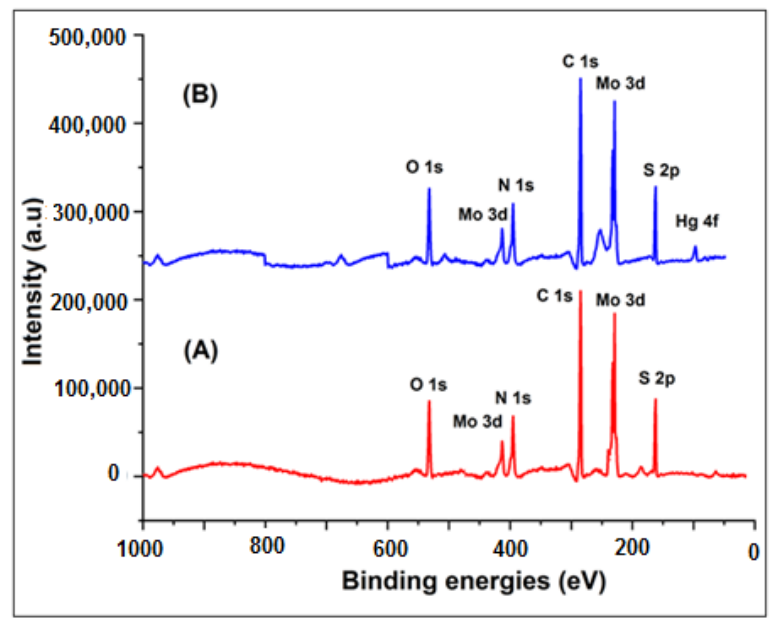
Figure 6. X-ray photoelectron spectra of PANI–MoS 2 ( A ) before Hg(II) adsorption and ( B ) after Hg(II) adsorption.